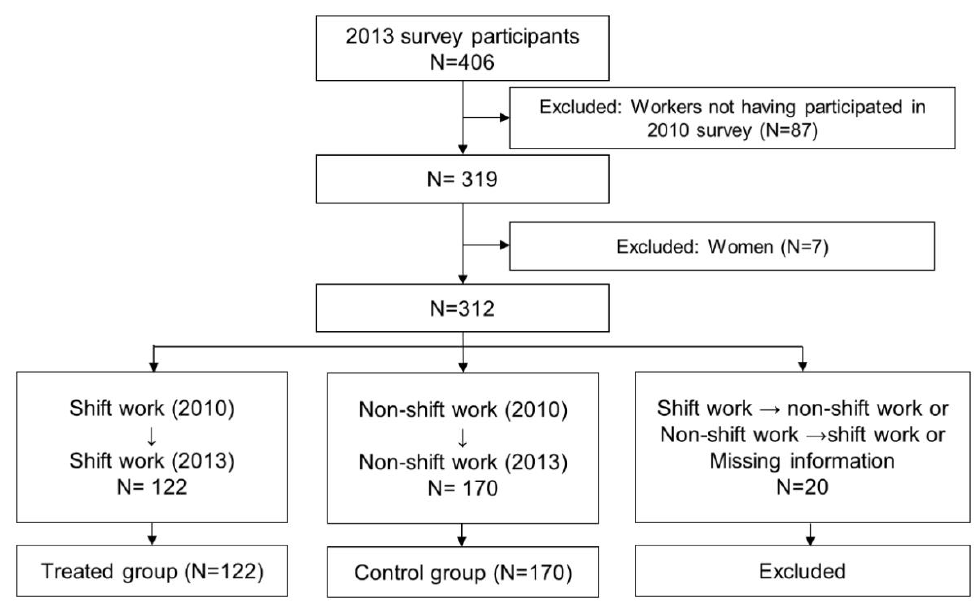
Figure 1. Flowchart of study subjects.